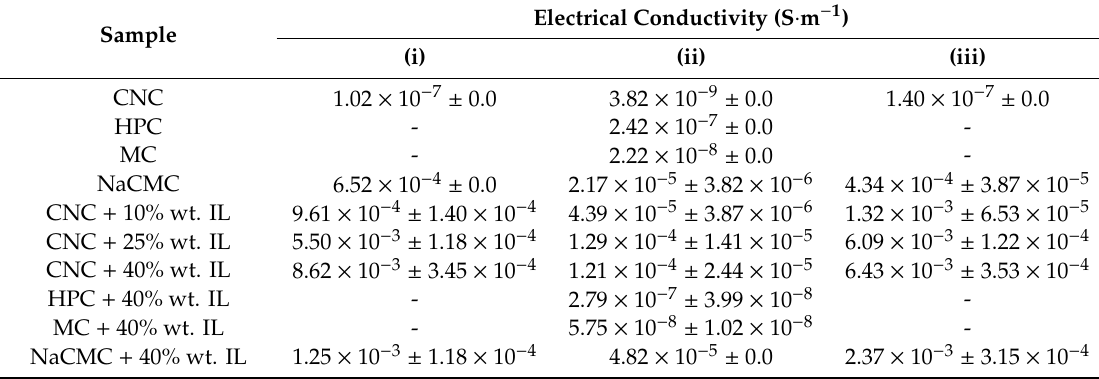
Table 2. Electrical conductivity of the neat cellulose derivatives and their IL-based